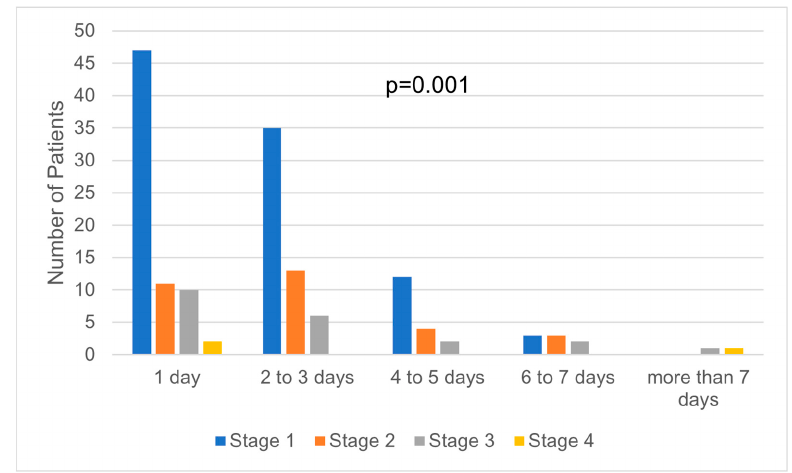
Figure 3. Correlation between tumor stage and time required to perform surgery.